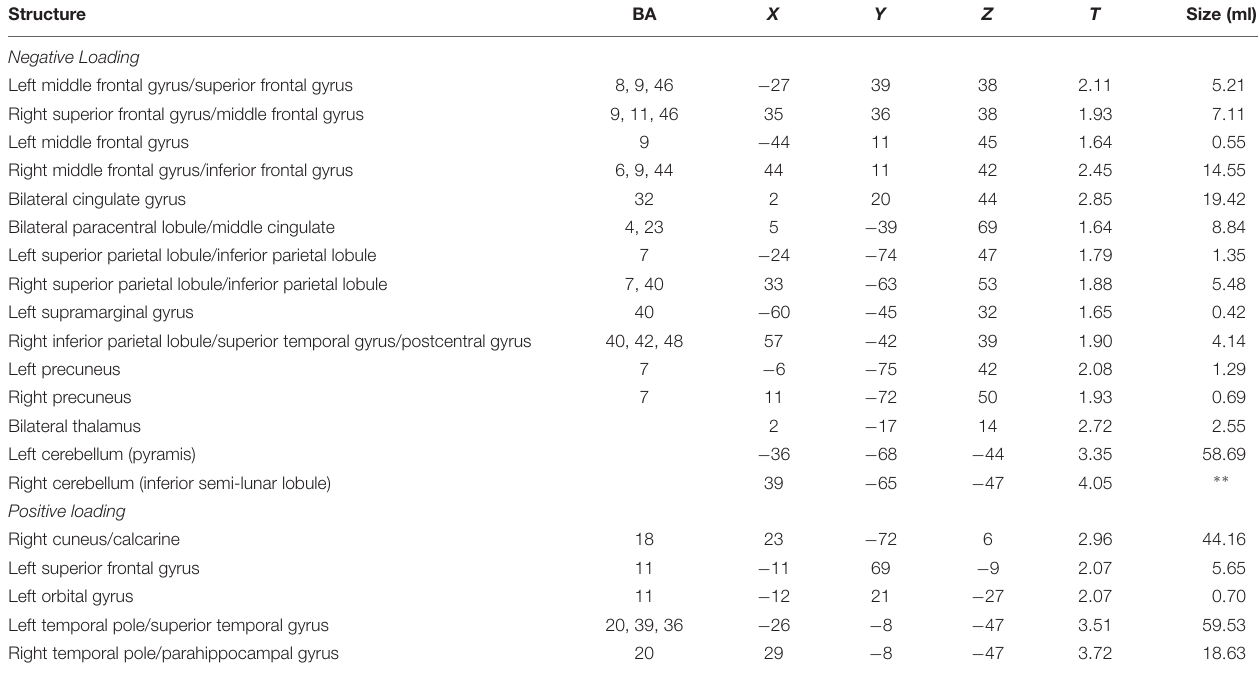
TABLE 4 | Regions of the age-related CBF pattern.